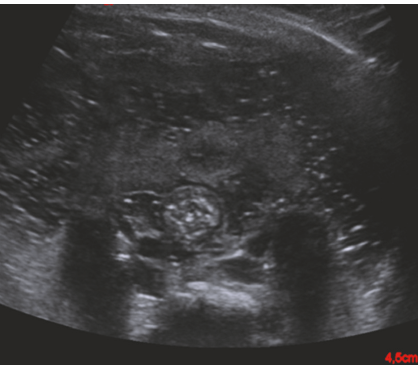
Figure 1: Ultrasound performed on the first day of life revealed free intraabdominal fluid.